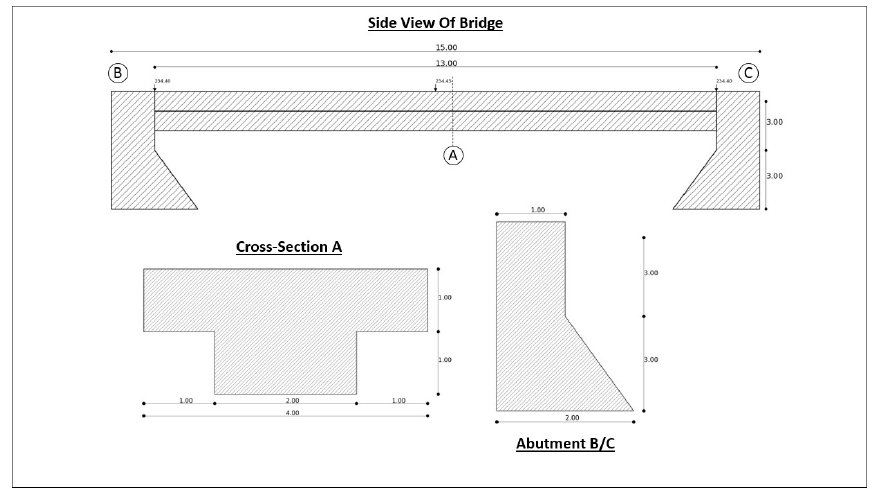
Figure 1. A sample of a side view of a bridge, showing the details of the cross-section of the upper structure and the abutment. The side view shows how the various parts come together to form the